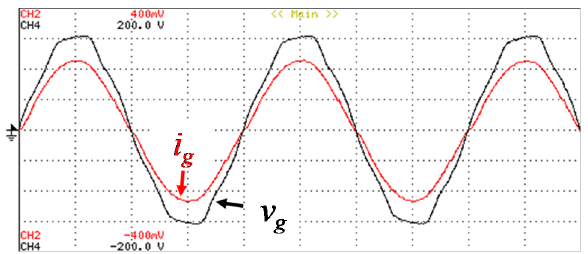
Figure 8. Experimental results during the MF-EVCS operation in G2V mode combined with the operation as APF: Ac-side voltage ( v g : 50 V/div); Total home current ( i g : 10 A/div).